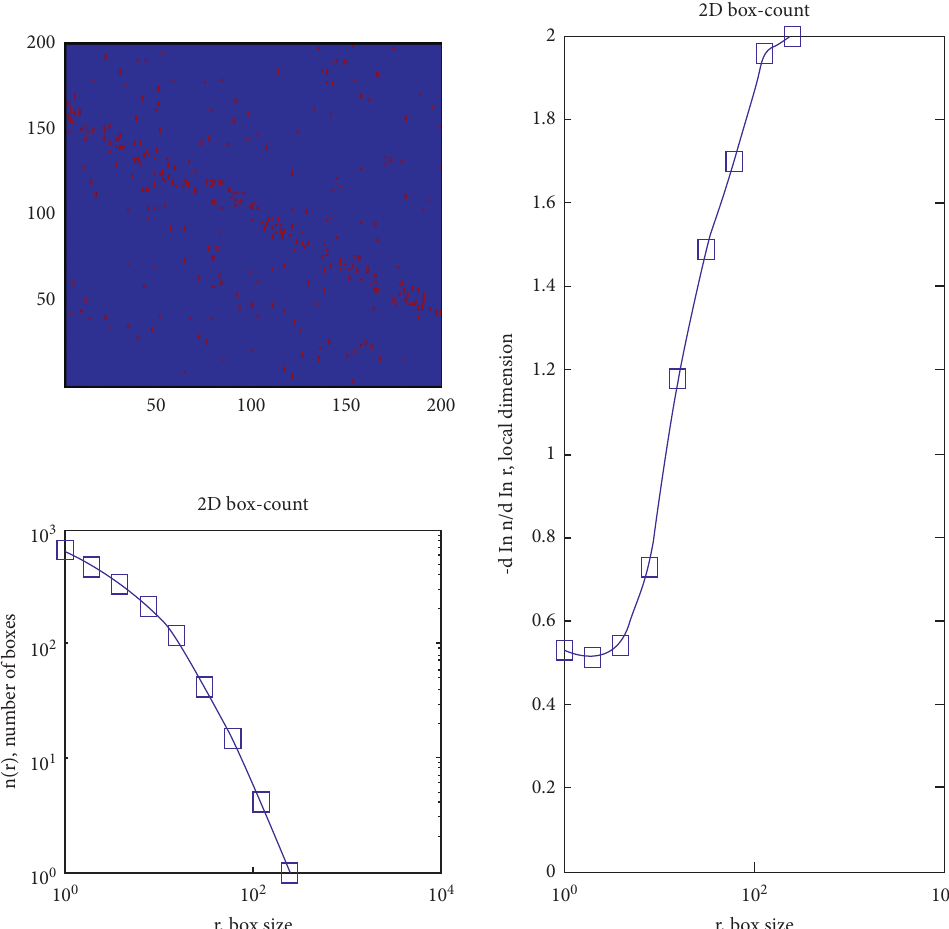
Figure 14: The calculation process of fractal dimension when the azimuth angle of the joint is 30 ° at stress level of